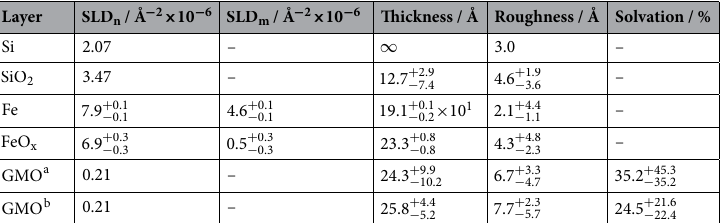
Table 2. Fitted layer parameters for the GMO-dodecane solutions entrained against an iron-coated silicon substrate at 7.0 × 10 2 s − 1 . The central parameter values are the median values obtained from the bootstrap routine, with the 95% confidence intervals reported in the sub- and superscripts. Those values without uncertainties were held constant. a Parameters used to model the sheared layer. b Parameters used to model the non-sheared